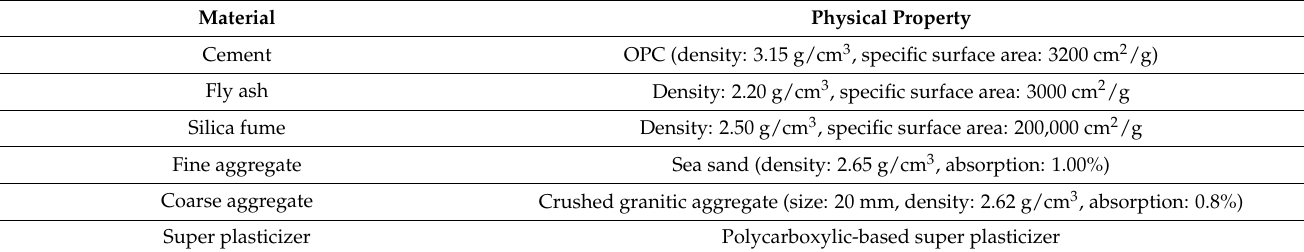
Table 3. Physical properties of the materials used in this